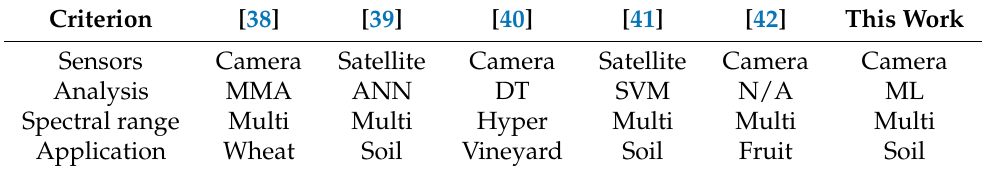
Table 1. Comparison of related